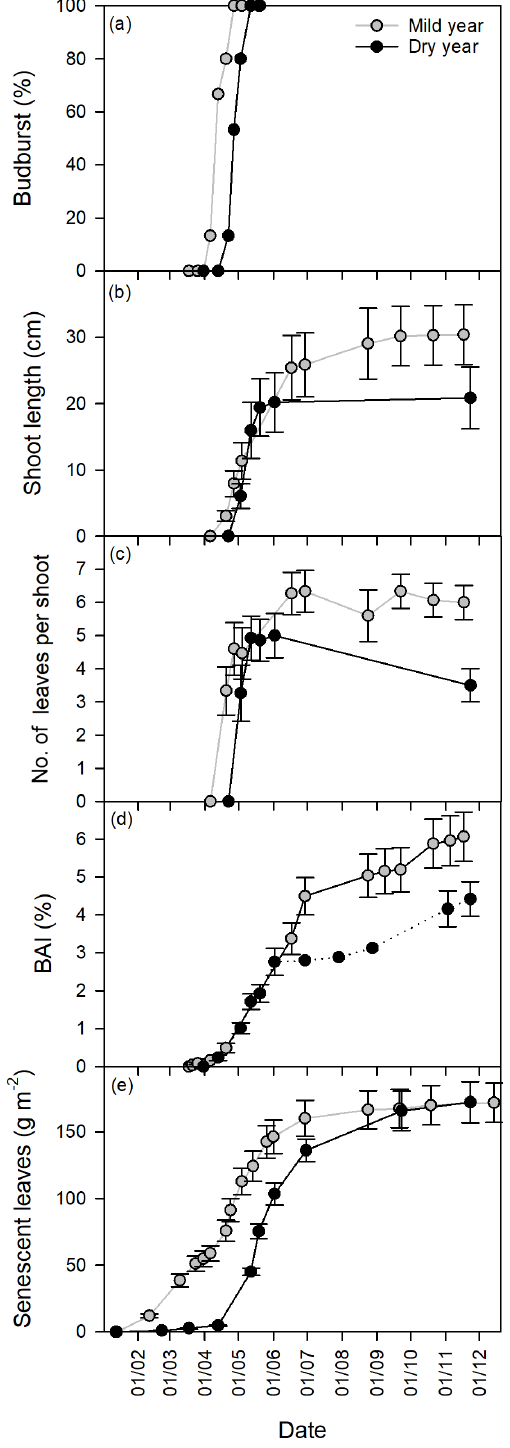
Figure 3. Growth dynamics in the mild and dry years, from Jan- uary to December. (a) Budburst (%). (b) Shoot elongation (cm). (c) Number of leaves per shoot. (d) Basal area increment (BAI, %). (e) Senescent leaves (gm − 2 ). Values are mean ± SEM ( n = 15).